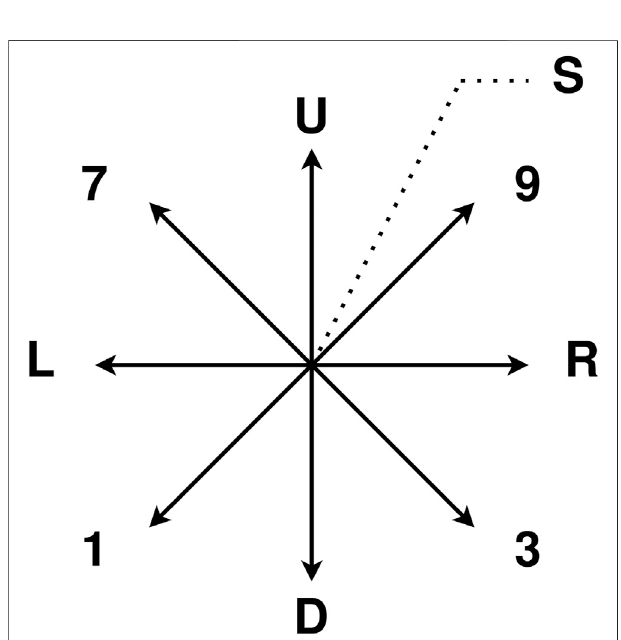
FIGURE 2 | Gaze gestures in camera sub-dataset of the HideMyGaze! dataset. “ U ” : gesture in up direction. “ D ” : gesture in down direction. “ L ” :